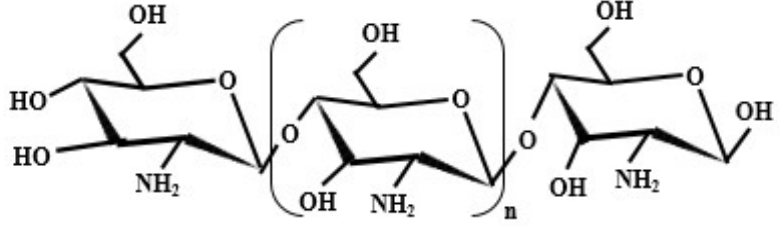
Figure 2. The chemical structure of chitosan.